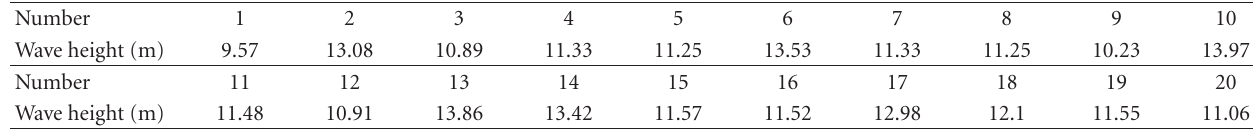
Table 1: Wave height data in the South China Sea from 1979 to 1987.